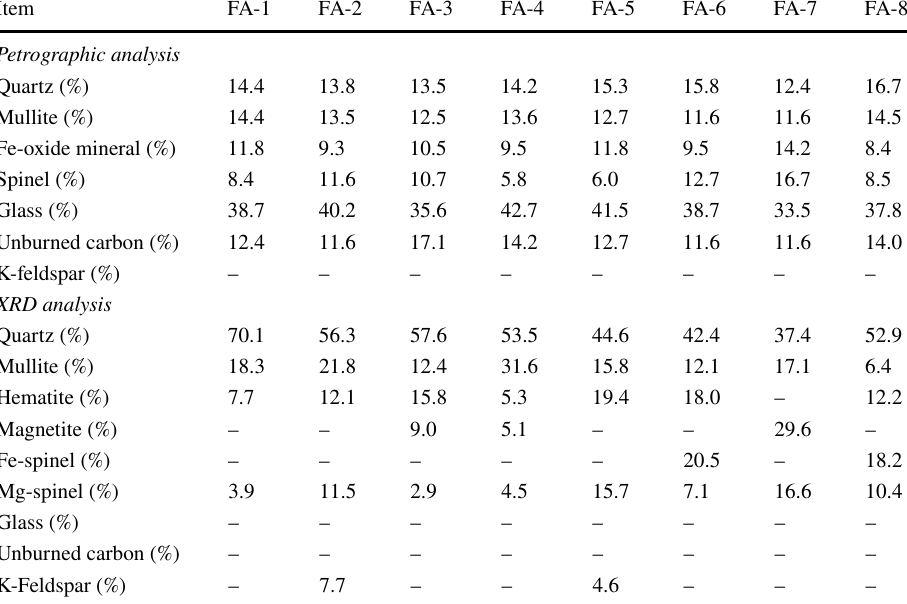
Table 4 Percentage of organic and inorganic components of fly ash (FA) samples based on petrographic and XRD analysis